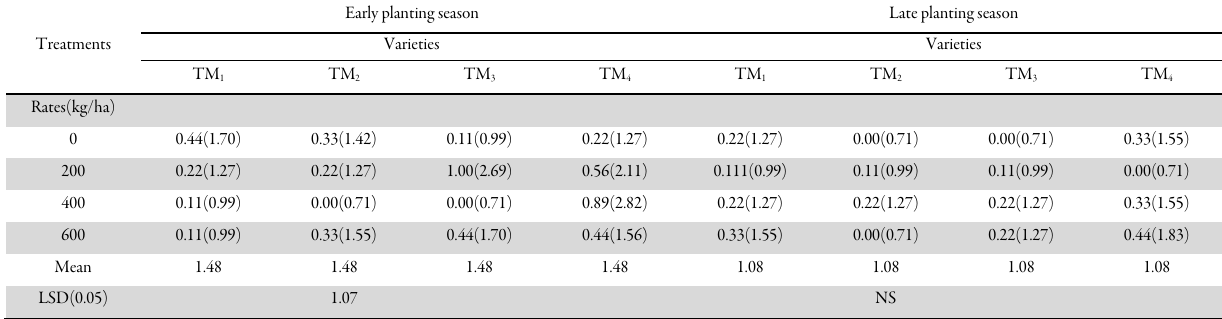
Table 3. Interaction effect of varieties and NPK fertilizer rates on the incidence of Z. variegatus on the field at 6MAP